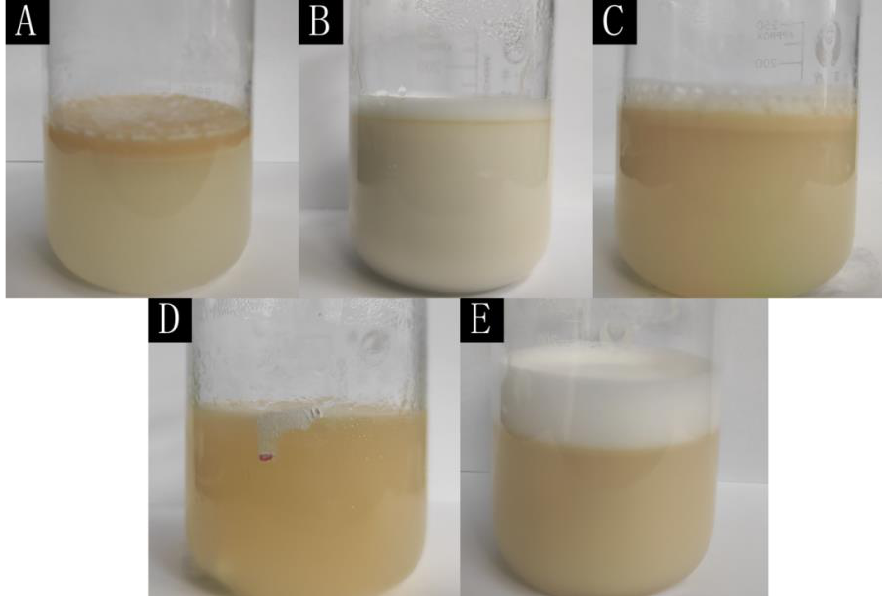
Figure 1. The core material emulsion emulsified by different emulsifiers: ( A ) Span-80, ( B ) SDBS, ( C ) OP-10, ( D ) Tween-80, ( E ) SDS.